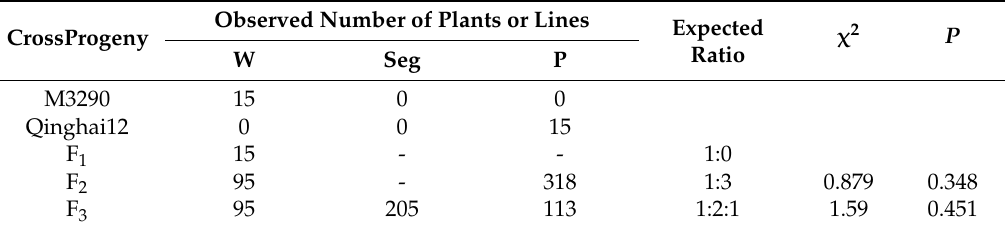
Table 1. Segregation for flower colours in the M3290/Qinghai12 F 1 , F 2 and F 2:3 progenies. Observed Number of Plants or Lines Expected Cross\Progeny